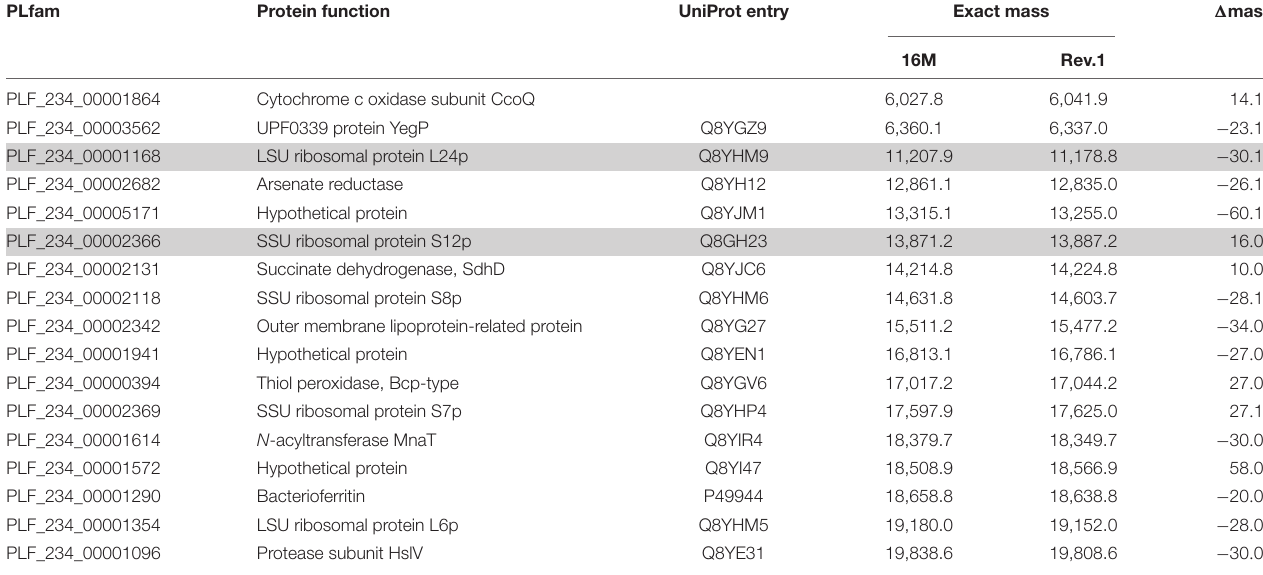
TABLE 1 | Short-listed proteins with discriminatory mass differences in the working range of MALDI-TOF MS. PLfam Protein function UniProt entry Exact